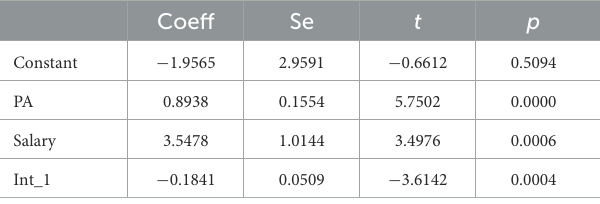
TABLE 10 Deep Acting and Personal Accomplishment, with salary as the moderator. Coeff p